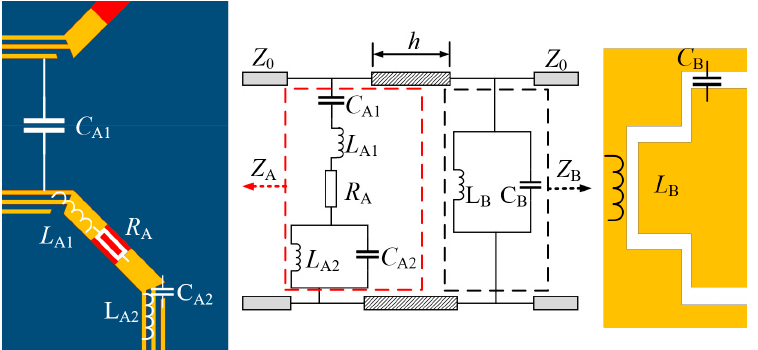
Figure 2. Equivalent circuit for the proposed FSR (optimized circuit parameters by ADS: R A = 256 Ω , C A1 = 0.117 pF, L A1 = 1.834 nH, C A2 = 0.20 pF, L A2 = 1.183 nH, L B = 1.022 nH, C B = 0.23 pF, the electrical length h is 90° at 10.8 GHz).